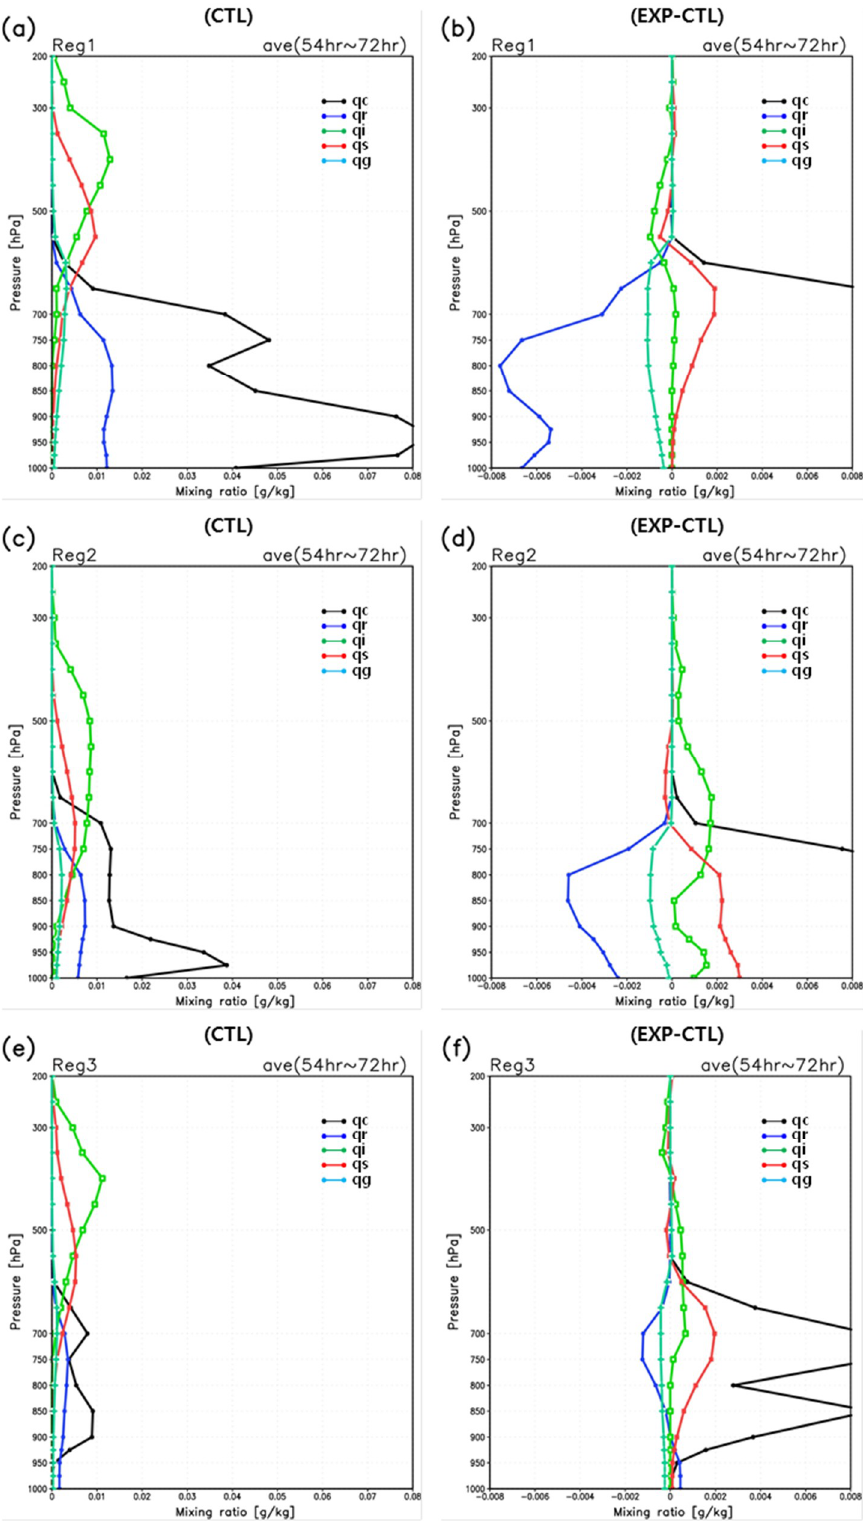
Figure 5. Vertical profiles of hydrometeors averaged for Regions ( a ) 1, ( c ) 2, and ( e ) 3 for the CTL run and the differences in hydrometeor concentrations (EXP minus CTL) for Regions ( b ) 1, ( d ) 2, and ( f ) 3.